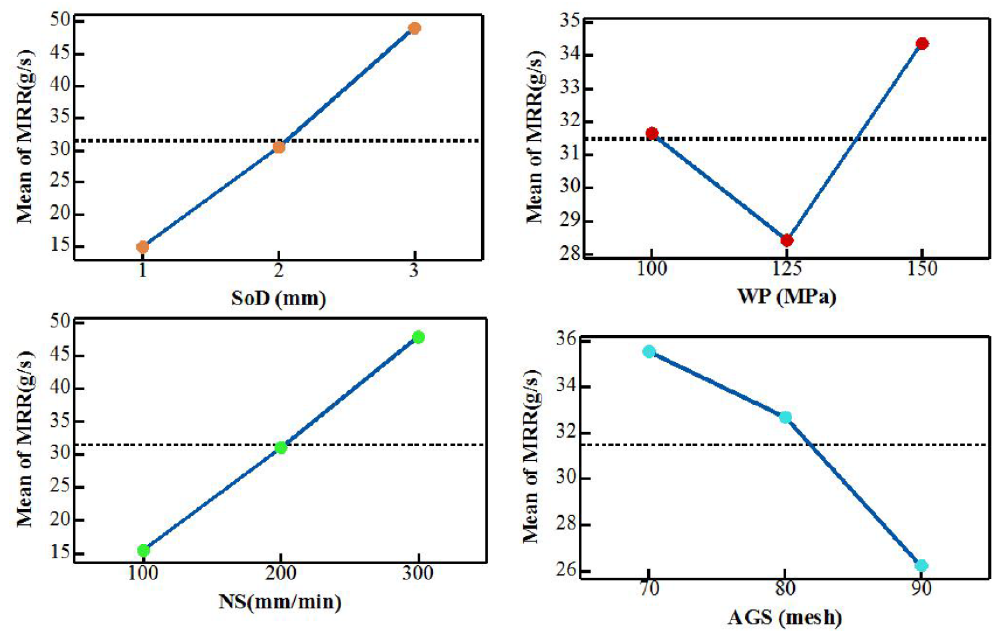
Figure 9. The effects of AWJM process parameters on MRR [45]. In addition, Jagadish et al. [45] and Jani et al. [16] were in full agreement on the influence of water pressure ( Wp ) and traverse speed ( Ts ) which meant that these two were the dominating parameters for MRR .